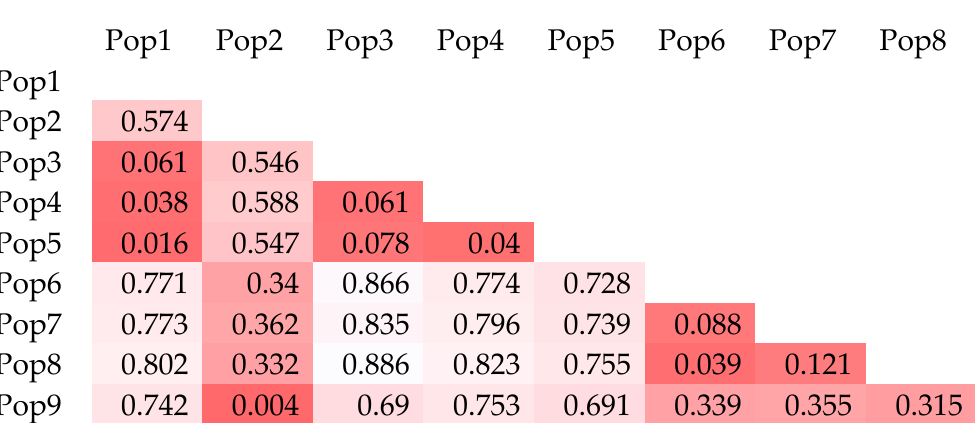
Table 4. Descriptive statistics of the overall loci for each population of A. marina : number of individuals (N), number of alleles (A), average number of alleles per locus (Na), percentage of polymorphic loci (Pic,%), number of effective alleles (Ne), observed heterozygosity (H o ), expected heterozygosity (H E ), Shannon’s information index (I), and fixation index (F).